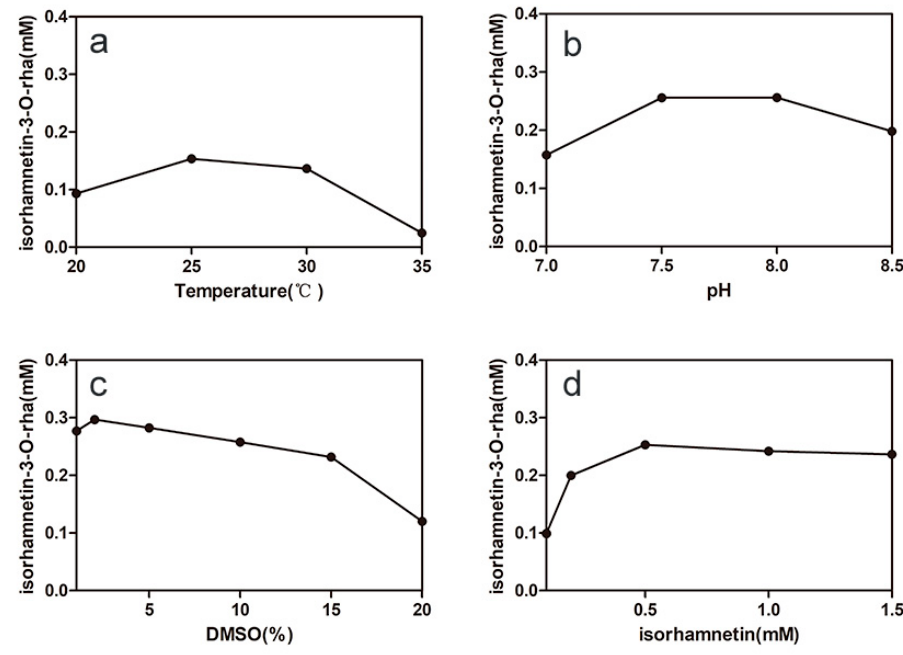
Figure 6. Optimization of bioconversion conditions for isorhamnetin-3- O -rhamnoside production by synergistic catalysis. Effects of temperature ( a ), pH ( b ), DMSO ( c ), and isorhamnetin ( d ) concentration on production. Values shown are the mean of duplicate experiments, and the variation about the mean was below 5%.